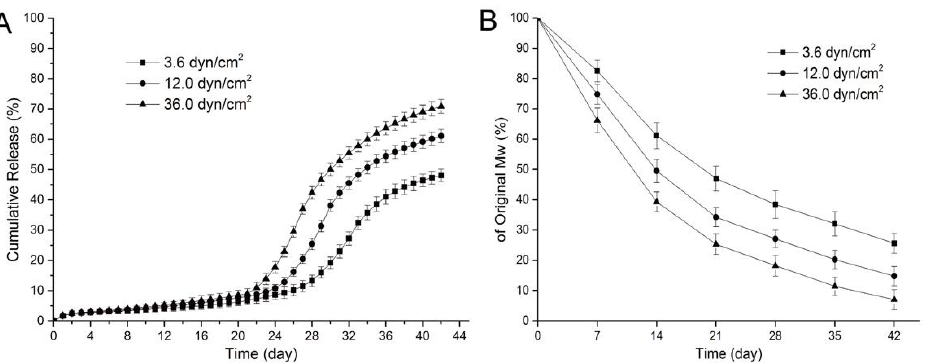
Figure 8. Release curves for sirolimus from poly(lactic- co -glycolic acid) (PLGA) for various shear stresses ( A ) and variations in the molecular weight of sirolimus-carrying PLGA films over time under various shear stresses ( B ). Adapted with permission from [66]; published by MDPI, 2017.